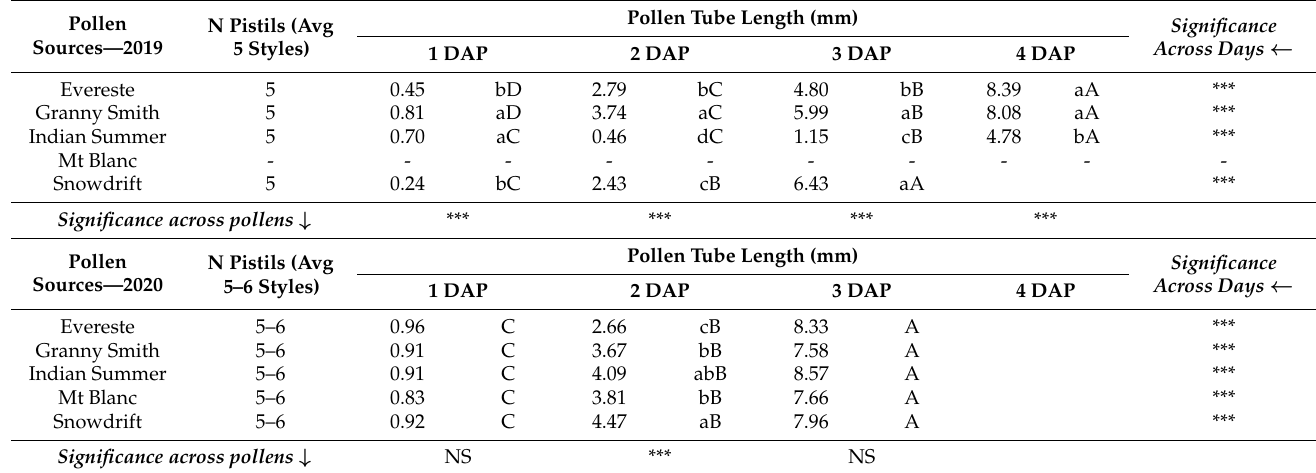
Table 1. ‘WA 38’ pollen tube length measurements in 2019 and 2020: Comparison between four pollen sources in 2019 and five pollen sources in 2020 for 4 and 3 days after pollination (DAP), respectively (1 DAP = 24 h). Significance of the model reported in the legend: *** p < 0.001 (proc GLM in SAS 9.4). Statistical letters originated from Student-Newman-Keuls post-hoc test with alpha = 0.05. Lowercase letters discriminate pollen tube length means across pollen sources within each day (vertically), while capital letters discriminate means for each pollen source across the 4 days (significance across days, horizontally). ‘WA 38’ styles’ average length was 11.2 mm in 2019 and 10.2 mm in 2020. The